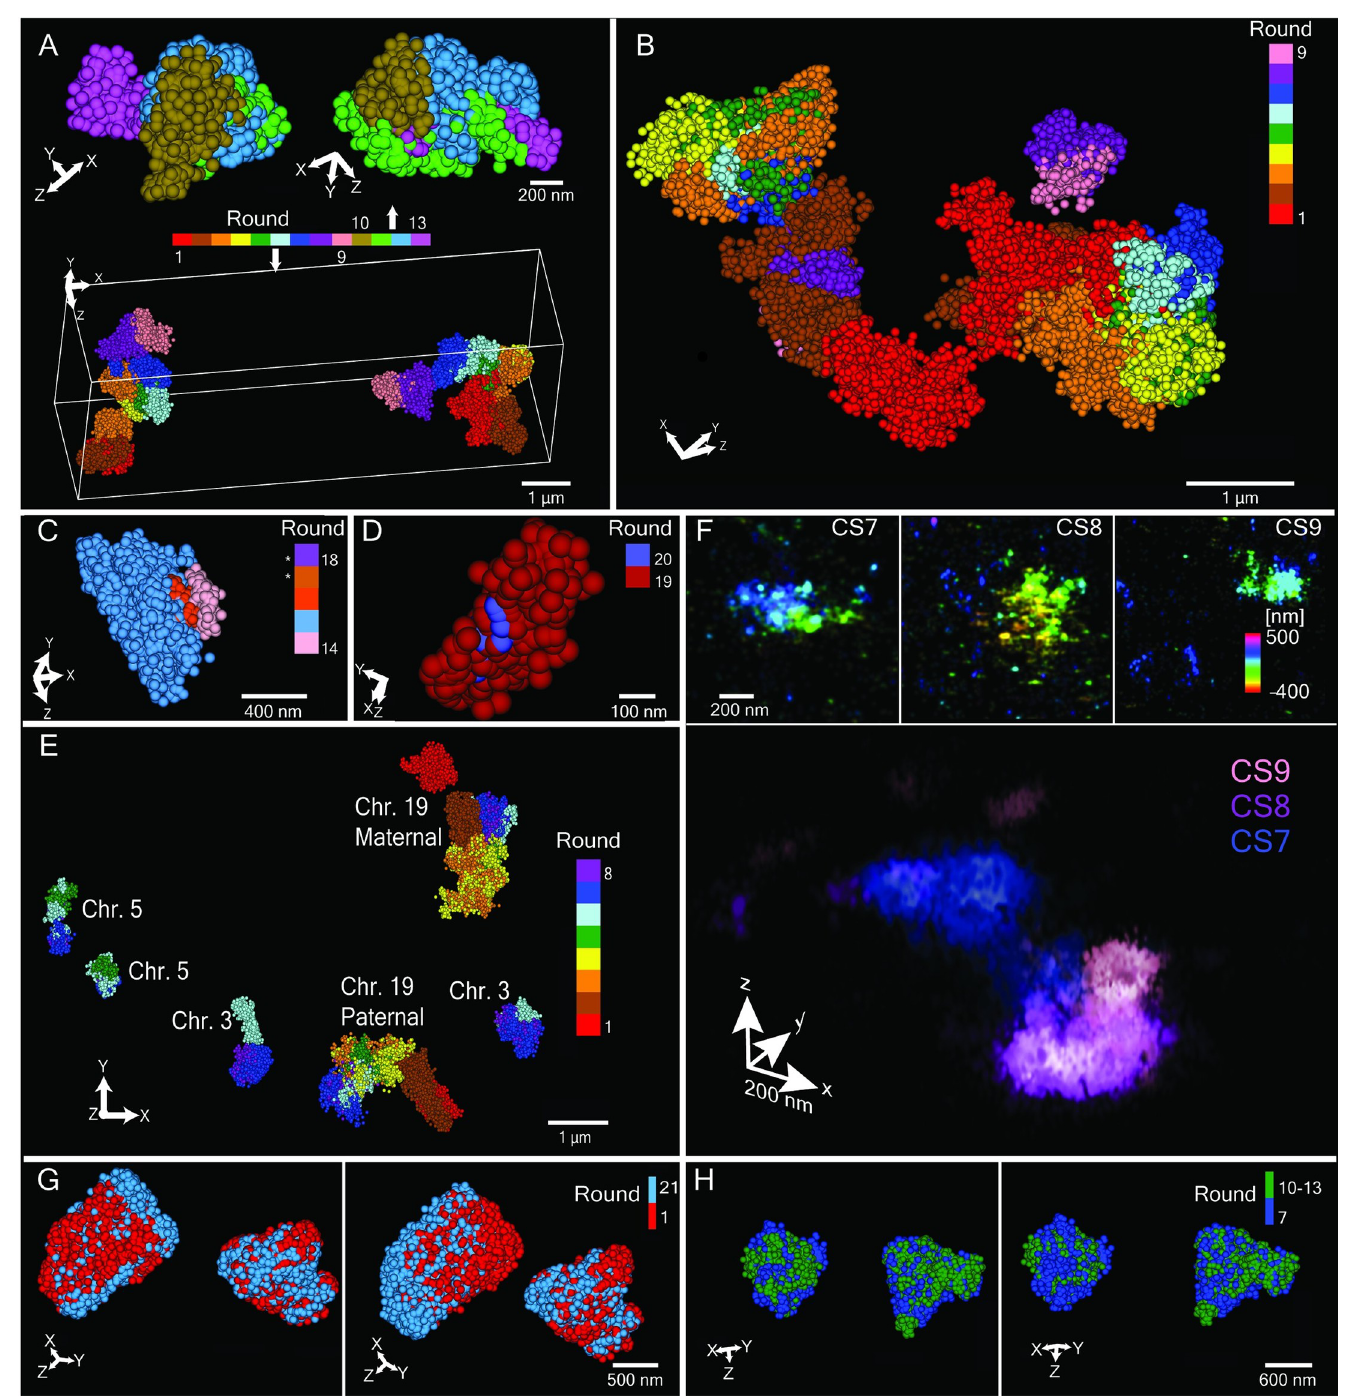
Fig 2. Tracing PGP1f chromosomes. ( A ) OligoSTORM image of a diploid nucleus showing CS1-9 (Bottom, rounds 1 through 9; 1.28, 1.24, 1.80, 1.04, 0.56, 0.52, 0.84, 0.52, and 0.36 Mb, respectively) and four subregions of CS7 (top, rounds 10 through 13; 140, 260, 350, and 90 kb, respectively) of both homologs. In this and all panels excepting F, radius of spheres represents the localization precision in the axial dimension. Note, the coordinates of the four subregions, selected based on the IMR-90 Hi-C map, correspond well to contact domains. Sequencing depth of the PGP1f Hi-C map was not, however, able to confirm these as contact domains in PGP1f, and thus they are referred to simply as subregions. ( B ) Same as in A with respect to CS1-9, but a different nucleus. ( C ) Loop (290 kb), including loop anchors (rounds 14 and 16; pink and orange; 10 kb each) and loop body (round 15; blue; 270 kb); � , we also imaged the upstream and downstream regions flanking the loop (rounds 17 and 18; 20 and 80 kb, respectively), but these are not shown so that the structure of the loop can be more apparent. ( D ) DNMT1 gene (round 19; 59.5 kb) and its DMR (round 20; 2.9 kb). ( E ) Walking along chromosome 19 in variable step sizes (see A) while also walking along chromosomes 3 and 5 in uniform step sizes (500 and 250